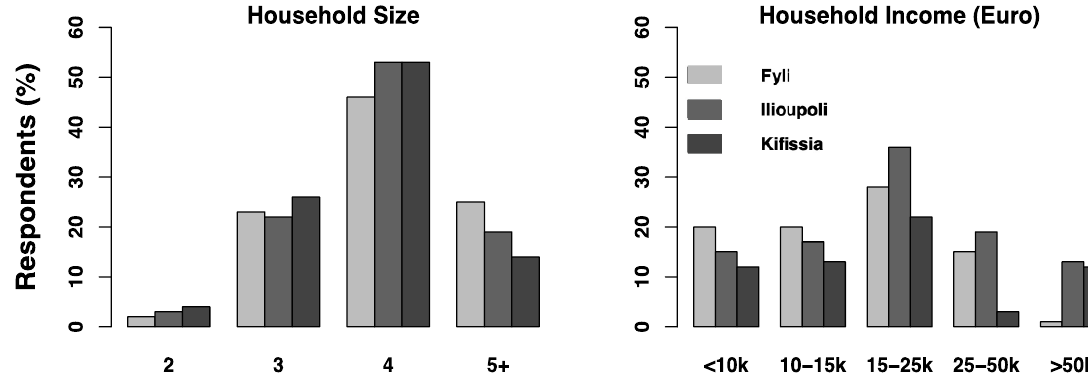
Figure 4 Data of respondents (parents) in each area